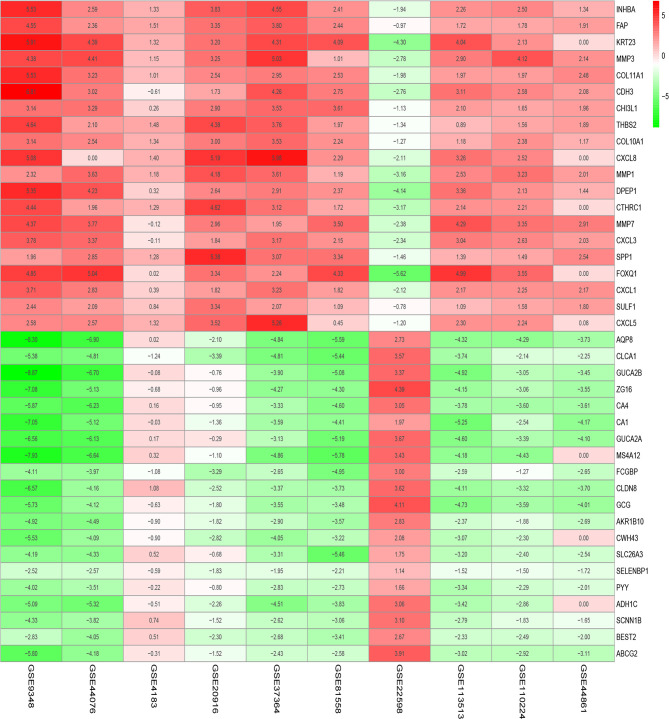
Significantly differentially expressed genes in Gene Expression Omnibus (GEO) datasets by robust rank aggregation (RRA) analysis. These heatmaps show the top 20 downregulated and top 20 upregulated genes. Each column indicates one dataset, and each row indicates one gene. Green indicates downregulation, and red indicates upregulation. The numbers in the heatmap indicate the logarithmic fold changes in the expression of each gene in the dataset.